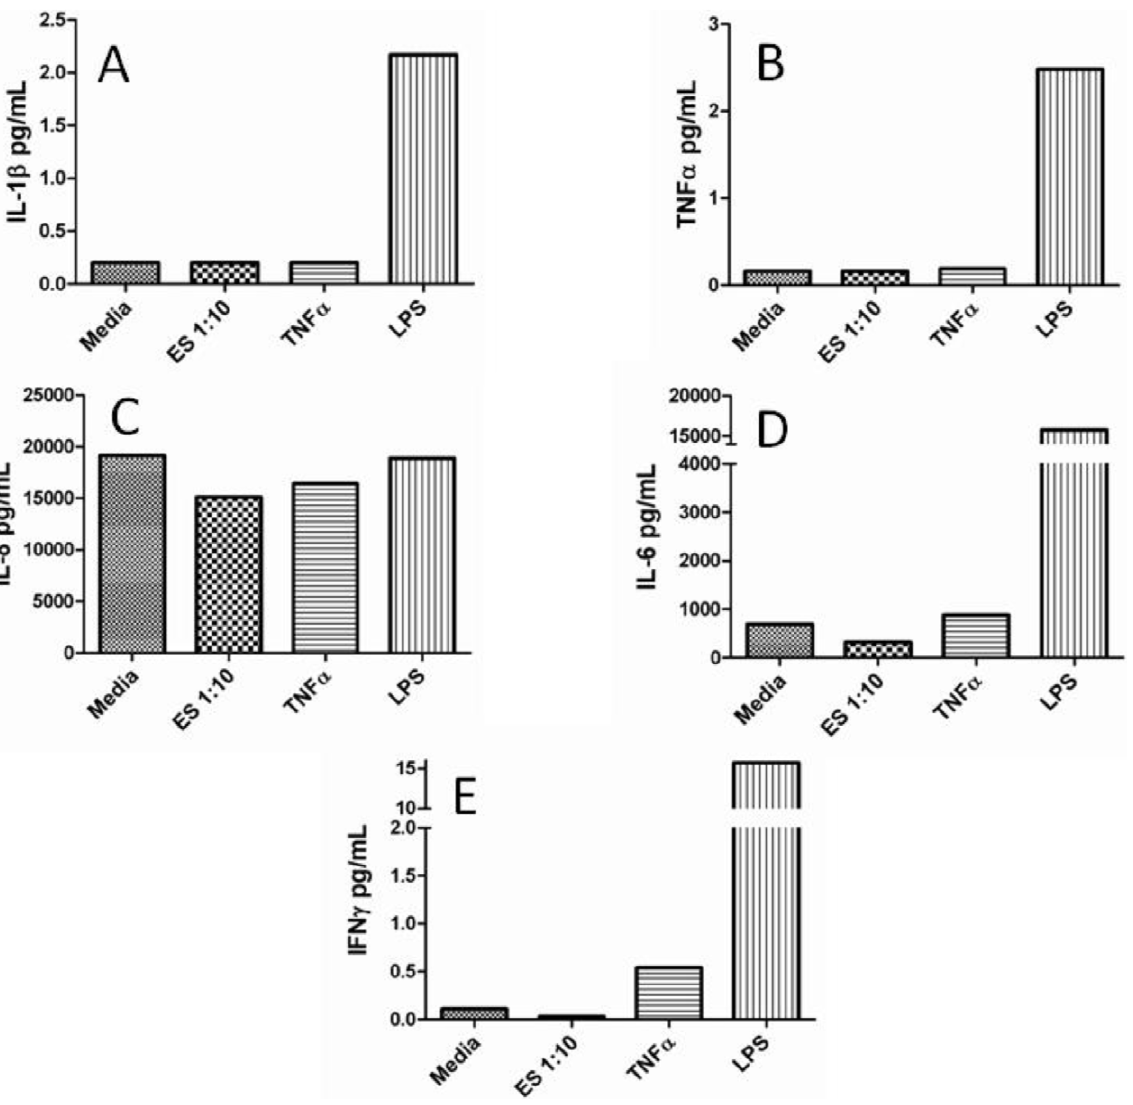
Figure 2. Cytokine production by LECs in response to filarial ES products. 3 6 10 5 LECs were plated in EGM-2MV media and allowed to come to confluence. Cells were then stimulated in EGM-2MV media with or without ES (1:10), LPS (100 ng/mL) or TNF a (10 ng/mL) for 72 hrs and supernatants were harvested and assessed for cytokine production including IL-1 b (A), TNF a (B), IL-8 (C), IL-6 (D) and IFN c (E) by luminex bead technology. Experiments were completed in triplicate and this figure includes representative data from one